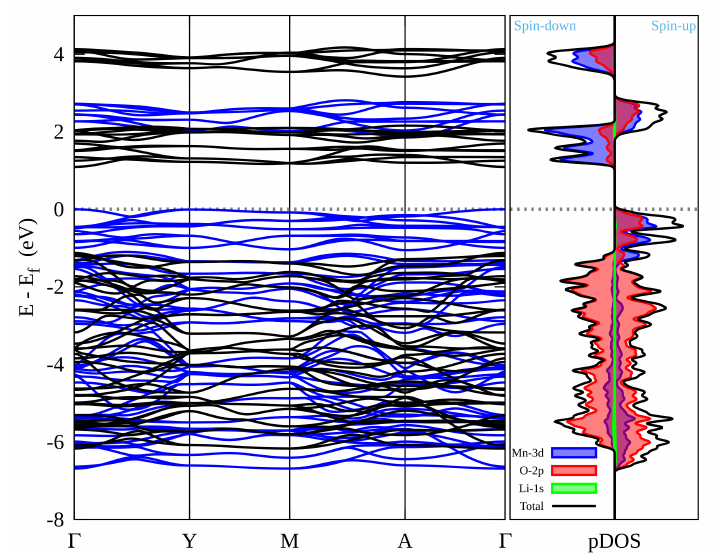
Figure 3. Electronic band structure and electronic density of states of Li 2 MnO 3 calculated by LDA. In the electronic band structure, the blue and black bands correspond to the spin-up and down,